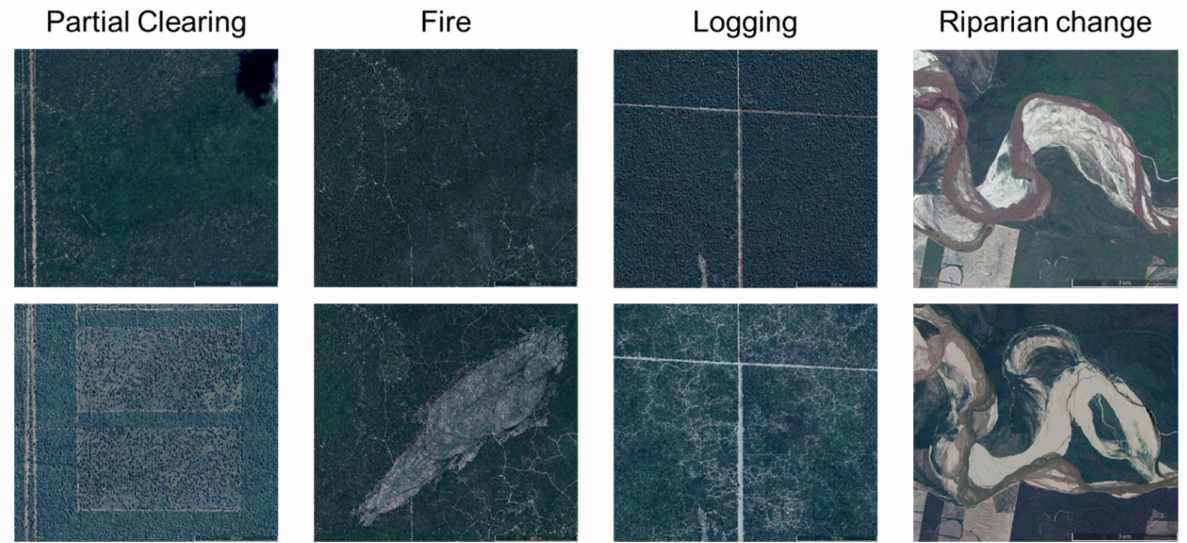
Figure 3. Examples of different disturbance agents as seen on very-high-resolution images from Google Earth. Top row : forests prior to the disturbance. Bottom row : post-disturbance situations. Columns: Partial clearing (in the example a silvopasture field); fire; logging; riparian change (in the example, the Bermejo river. Note how mutable the river meanders